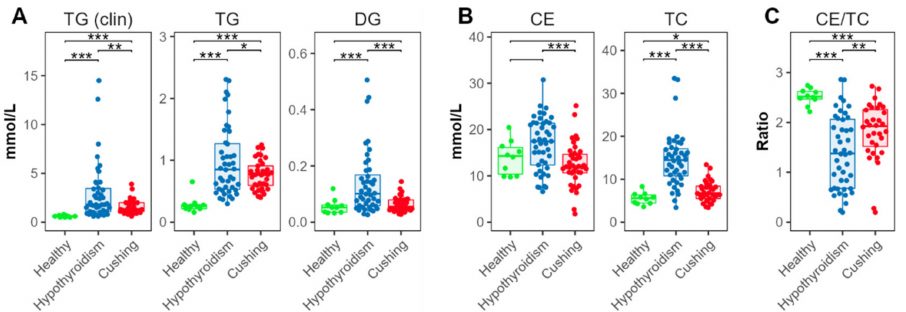
Figure 2. Triglyceride and cholesterol concentrations. ( A ) Total triglyceride (TG) and diacylglyceride (DG). ( B ) Total esterified (cholesteryl esters, CE) and total cholesterol (TC) concentrations. ( C ) Ratios between esterified and total cholesterol. TG (clin) and TC were determined using colorimetric clinical chemistry assays, the other lipid classes via the lipidomics platform. Levels of statistical significance between two groups calculated by two-tailed Welch’s t -tests are indicated with stars: * p ≤ 0.05, ** p ≤ 0.01, *** p ≤